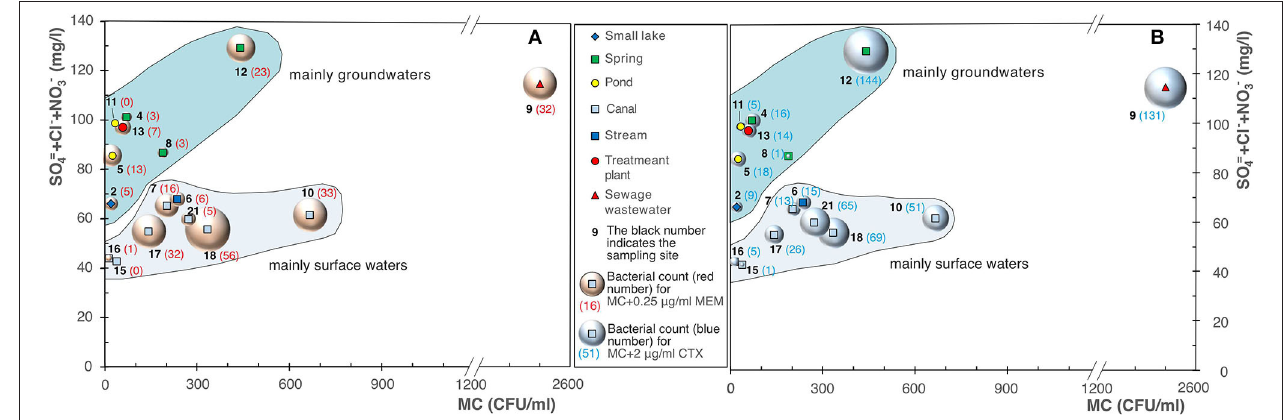
FIGURE 11 | Bubble diagrams of bacterial counts on MacConkey agar (MC) vs. SO = 4 + Cl − + NO − 3 . (A) MC with addition of 0.25 µ g/ml of meropenem (MEM); (B) MC added with 2 µ g/ml of cefotaxime (CTX).